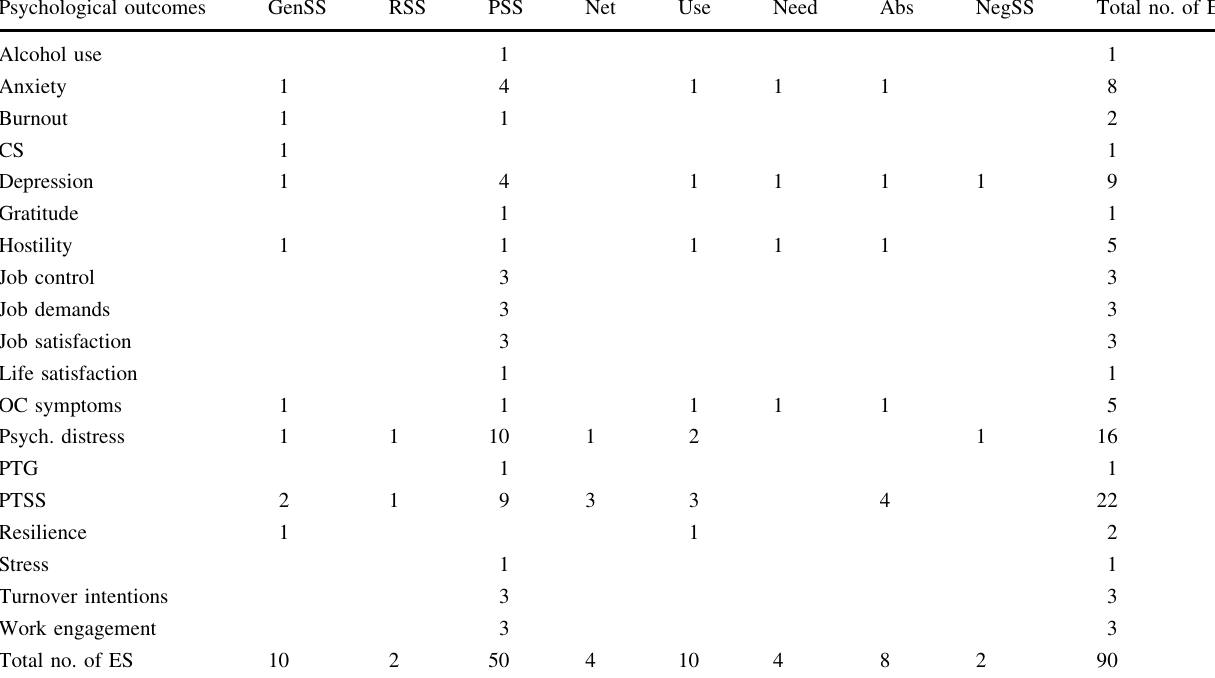
Table 2 Number of effect sizes of associations of social support type and psychological outcomes in disaster responders Psychological